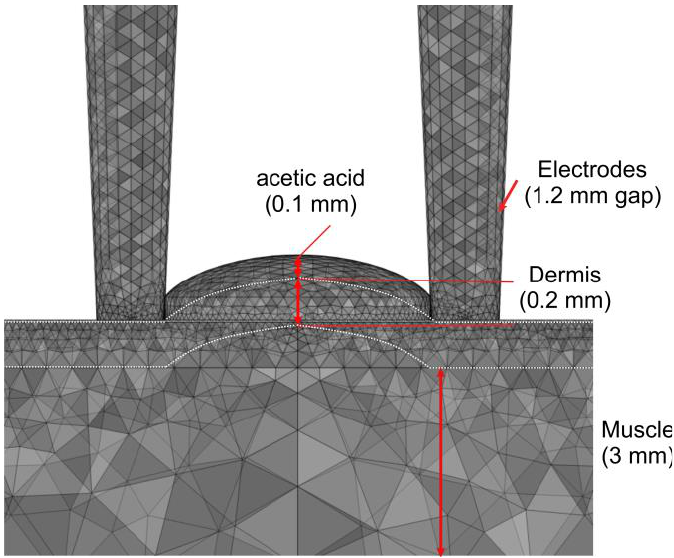
Figure 3. The mesh structure of the skin treatment using tweezer